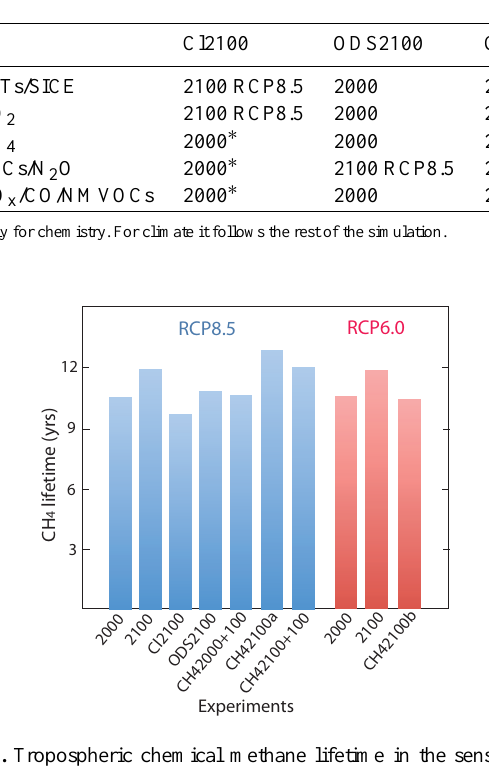
Table 3. List of sensitivity experiments.